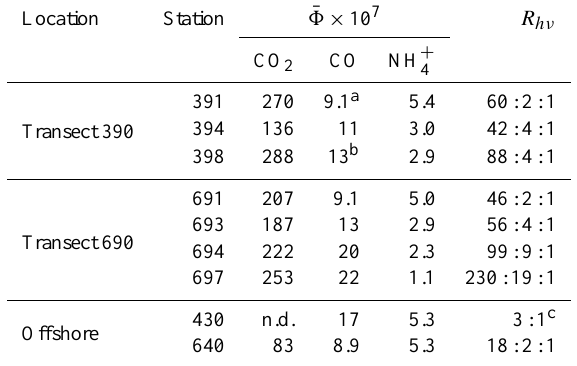
Table 4. Comparision of ¯ 8 among NH + , CO 2 and CO. ¯ 8 is defined 4 in Eq. (5) in the text. R hν is the molar ratio of CO 2 :CO:NH + equal to ¯ 8 CO : ¯ 8 CO : ¯ 8 . n.d. = not determined. NH + 4 2